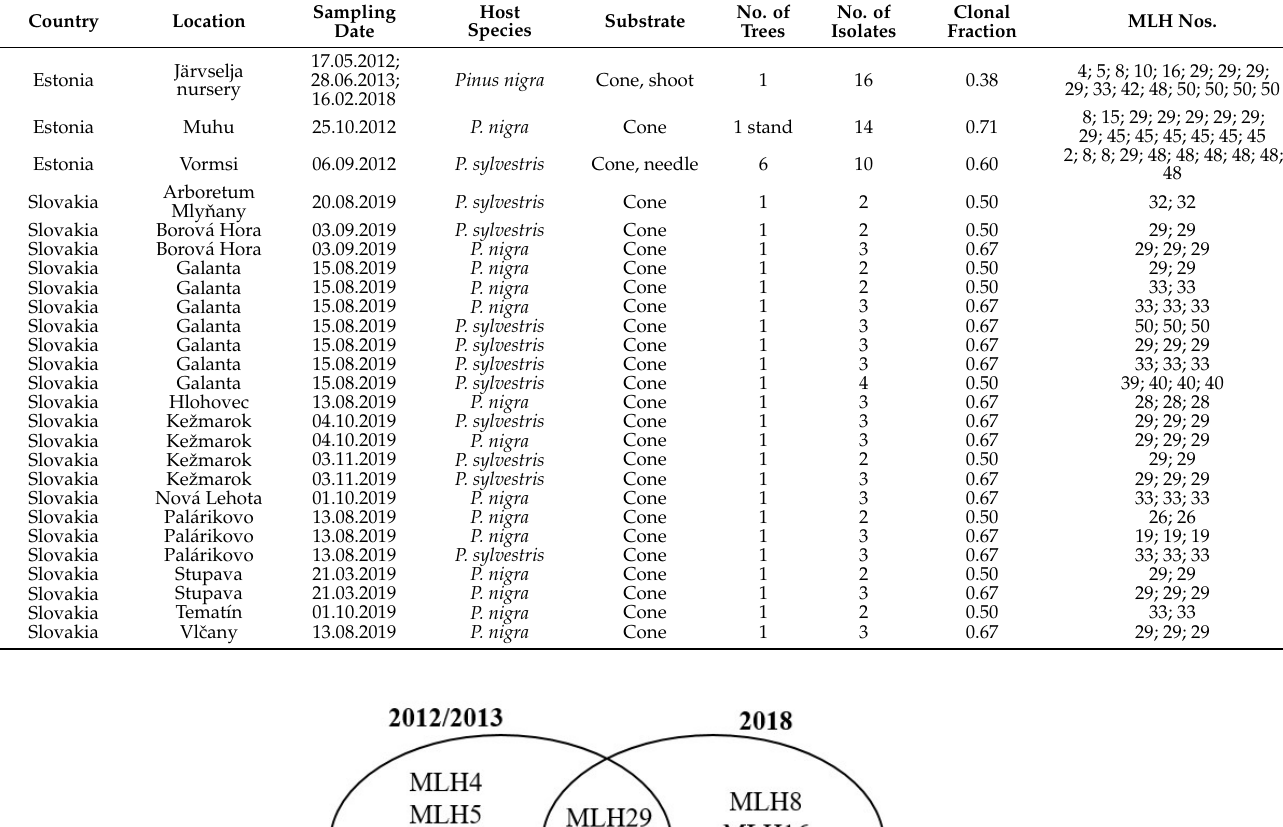
Table 8. Diversity of D. sapinea in single trees and small groups of nearby trees.